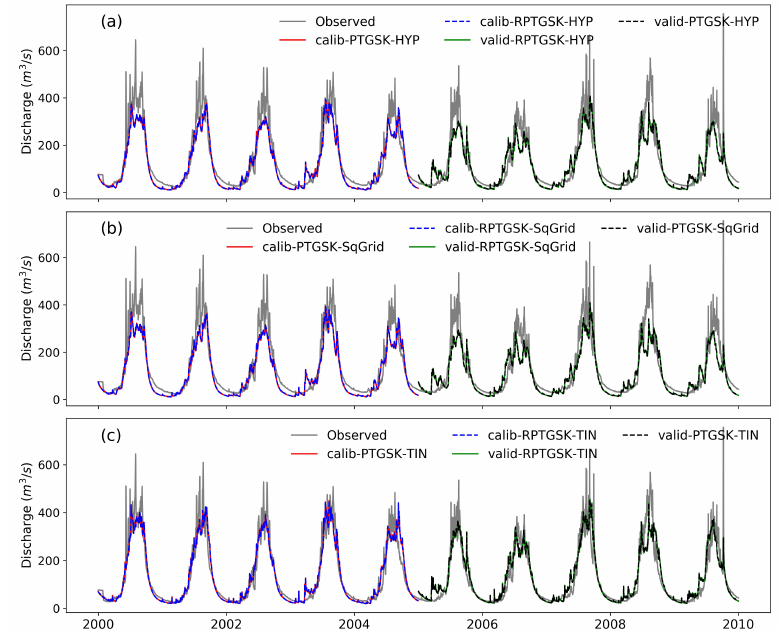
Figure 6. Observed and simulated discharge from different models under the two radiation models i.e., PTGSK and RPTGSK for the discretizations, i.e., hypsography ( a ), square grid ( b ), and traingulated irregular network ( c ). In the figures legends, “Calib” and “valid” represent model calibration and validation,